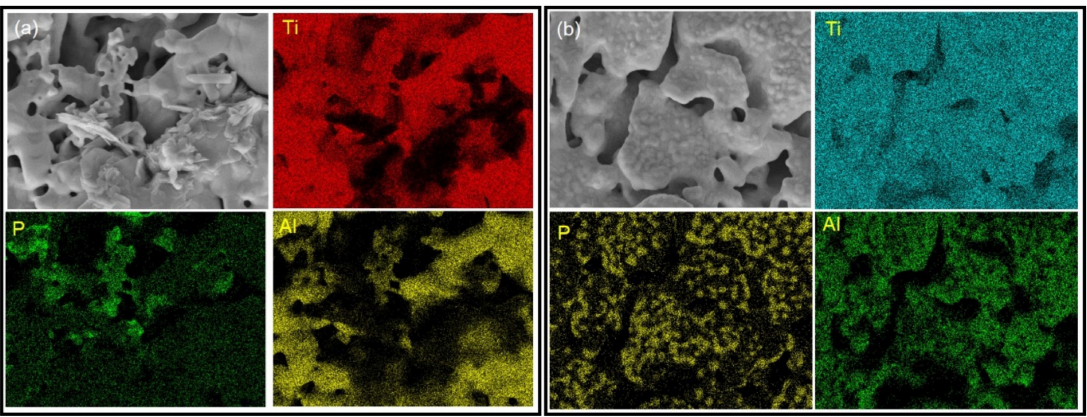
Figure 5. ( a ) Ti-HA(1) and ( b )